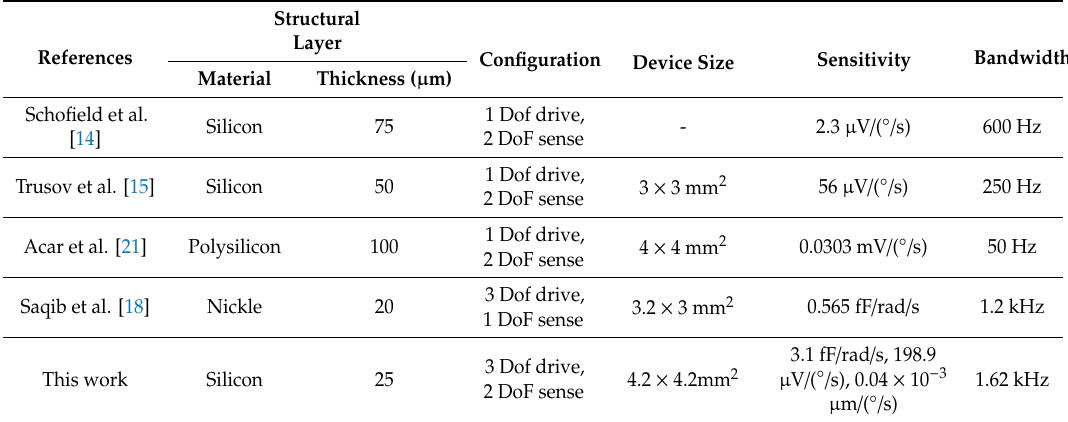
Table 4. Comparison of the proposed multi-DoF MEMS gyroscope design with the